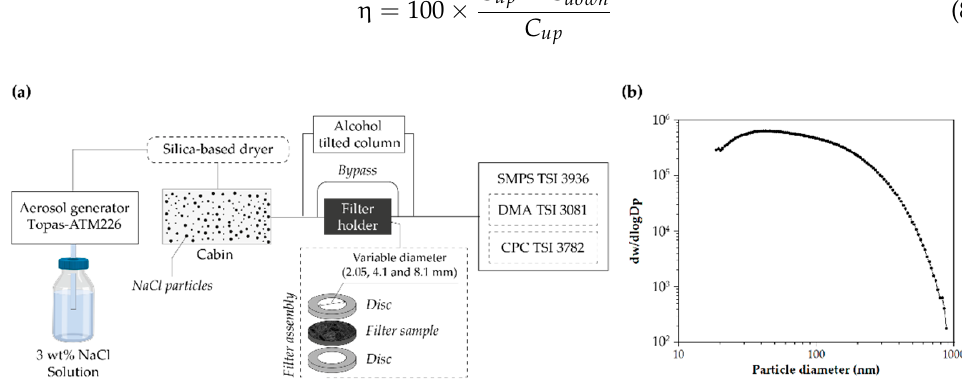
Figure 3. Performance test. ( a ) Diagram of the equipment used to characterize the filters and ( b ) particle concentration distribution for efficiency determination measurements in the range 0.1–1.0 µm.